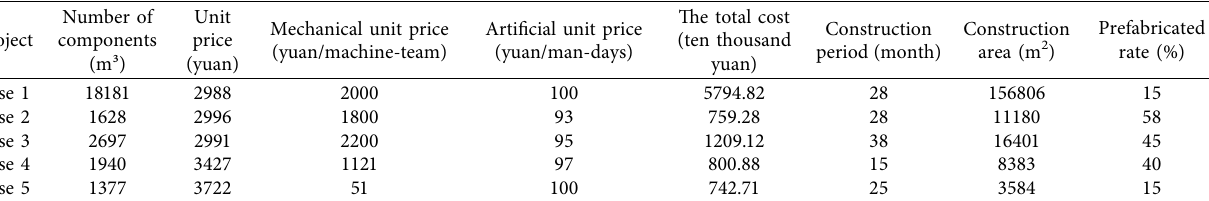
Table 3: Basic information of prefabricated projects cases.